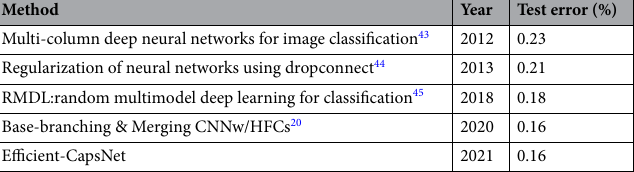
Table 3. Test error (%) on the MNIST classification task of state-of-the-art methodologies based on ensemble over the years.